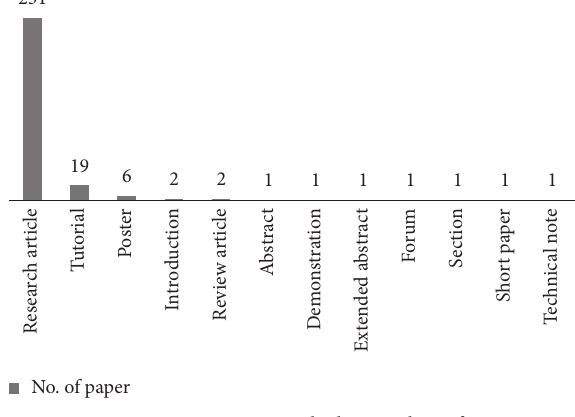
Figure 6: Content types with the number of papers.